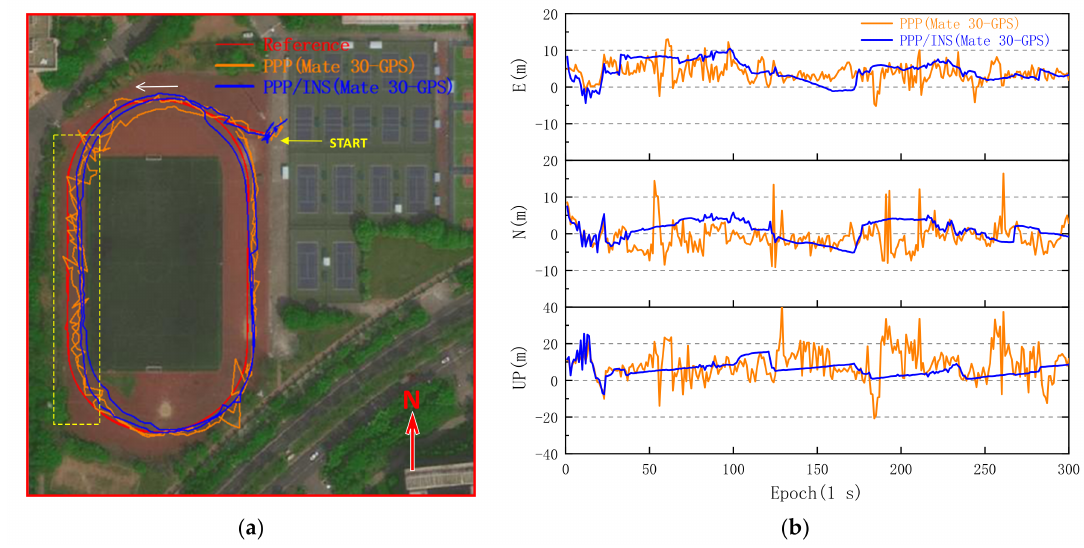
Figure 12. GPS PPP and PPP/INS solutions from Huawei Mate 30 on the playground. ( a ) Trajectories of GPS PPP and PPP/INS solutions. ( b ) Comparison of GPS PPP and PPP/INS solutions with reference points.